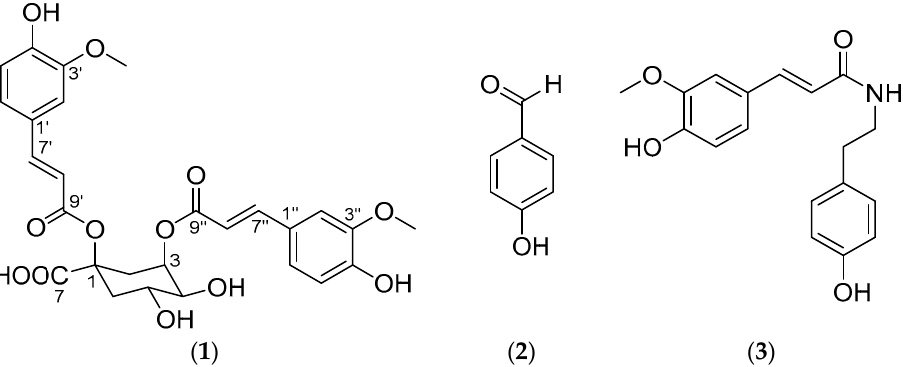
Figure 1. Chemical structures of compounds 1 to 3 ; ( 1 ) 1,3-di- O - trans -feruloyl-( − )-quinic acid, ( 2 ) p -hydroxybenzaldehyde, and ( 3 ) N - trans -feruloyltyramine. Table 3. NMR data of 1,3-di- O - trans -feruloyl-( − )-quinic acid ( 1 ) in CD 3 OD